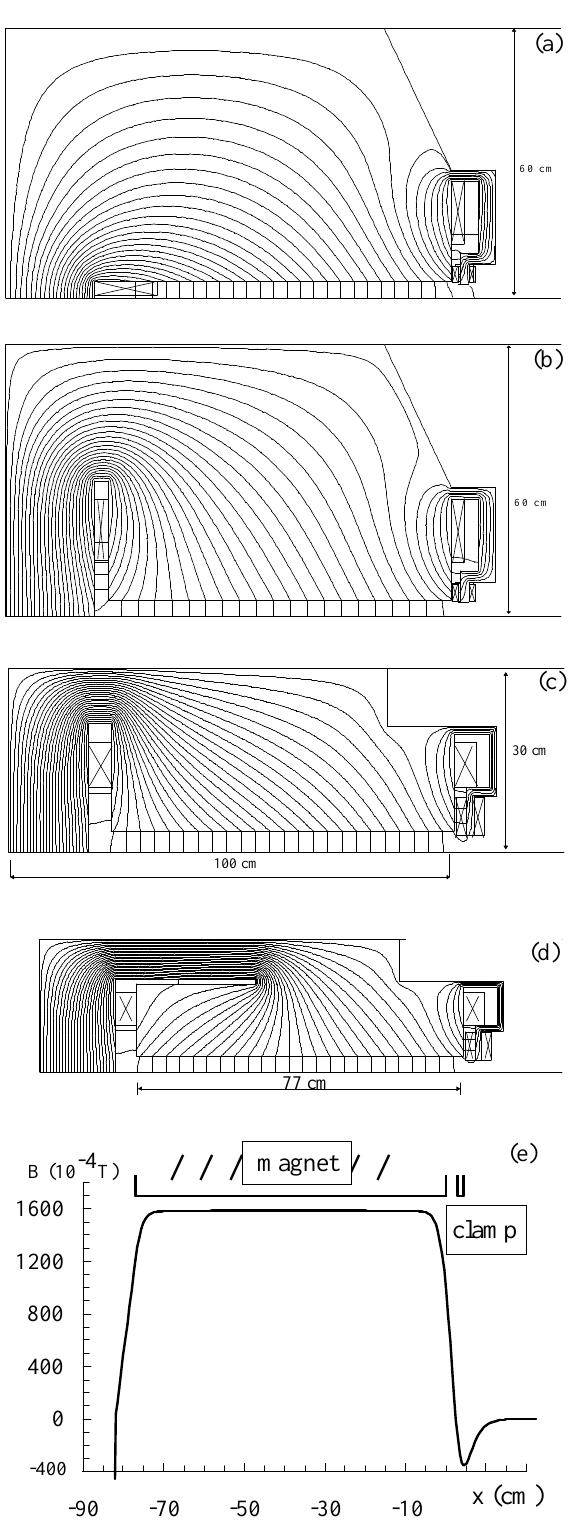
FIG. 1. The design of a racetrack microtron end magnet: (a) HPF configuration (magnet 1), (b) high C configuration (magnet 2), (c) low C configuration (magnet 3), and (d) low C configuration with homogenizing air gaps of 1 cm (magnet 4) and the magnetic field distribution in the middle plane, as a function of distance to the pole edge.